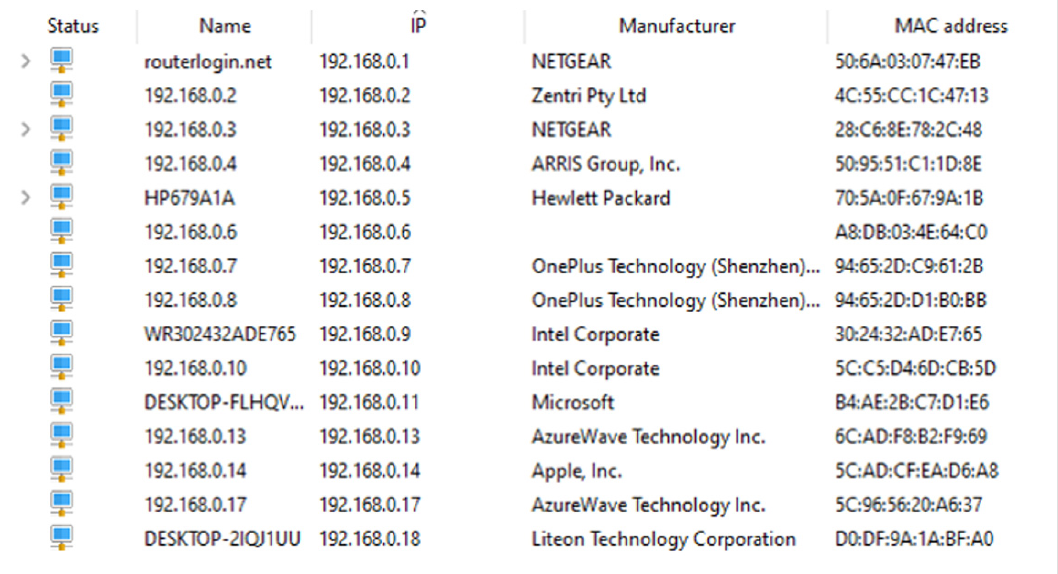
Figure 13. IoT Devices connected to the home network using IP scanner.